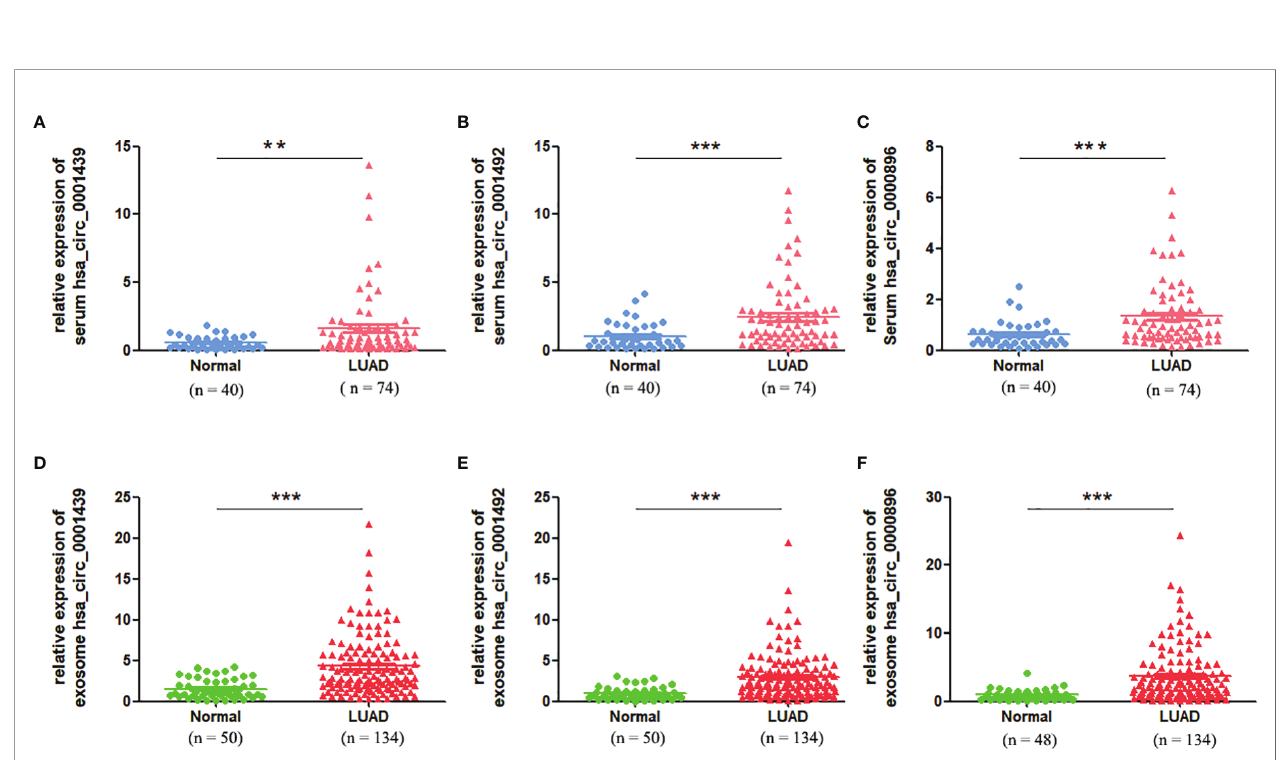
FIGURE 1 | The shapes of serum exosomes from healthy controls (A) and LUAD patients (B) were photographed by transmission electron microscopy. Size analyses of serum exosomes from healthy controls and LUAD patients were performed by nanoparticle tracking analysis (C) . The exosomal markers CD9, CD63, and Syntenin were measured by Western blot (D) .